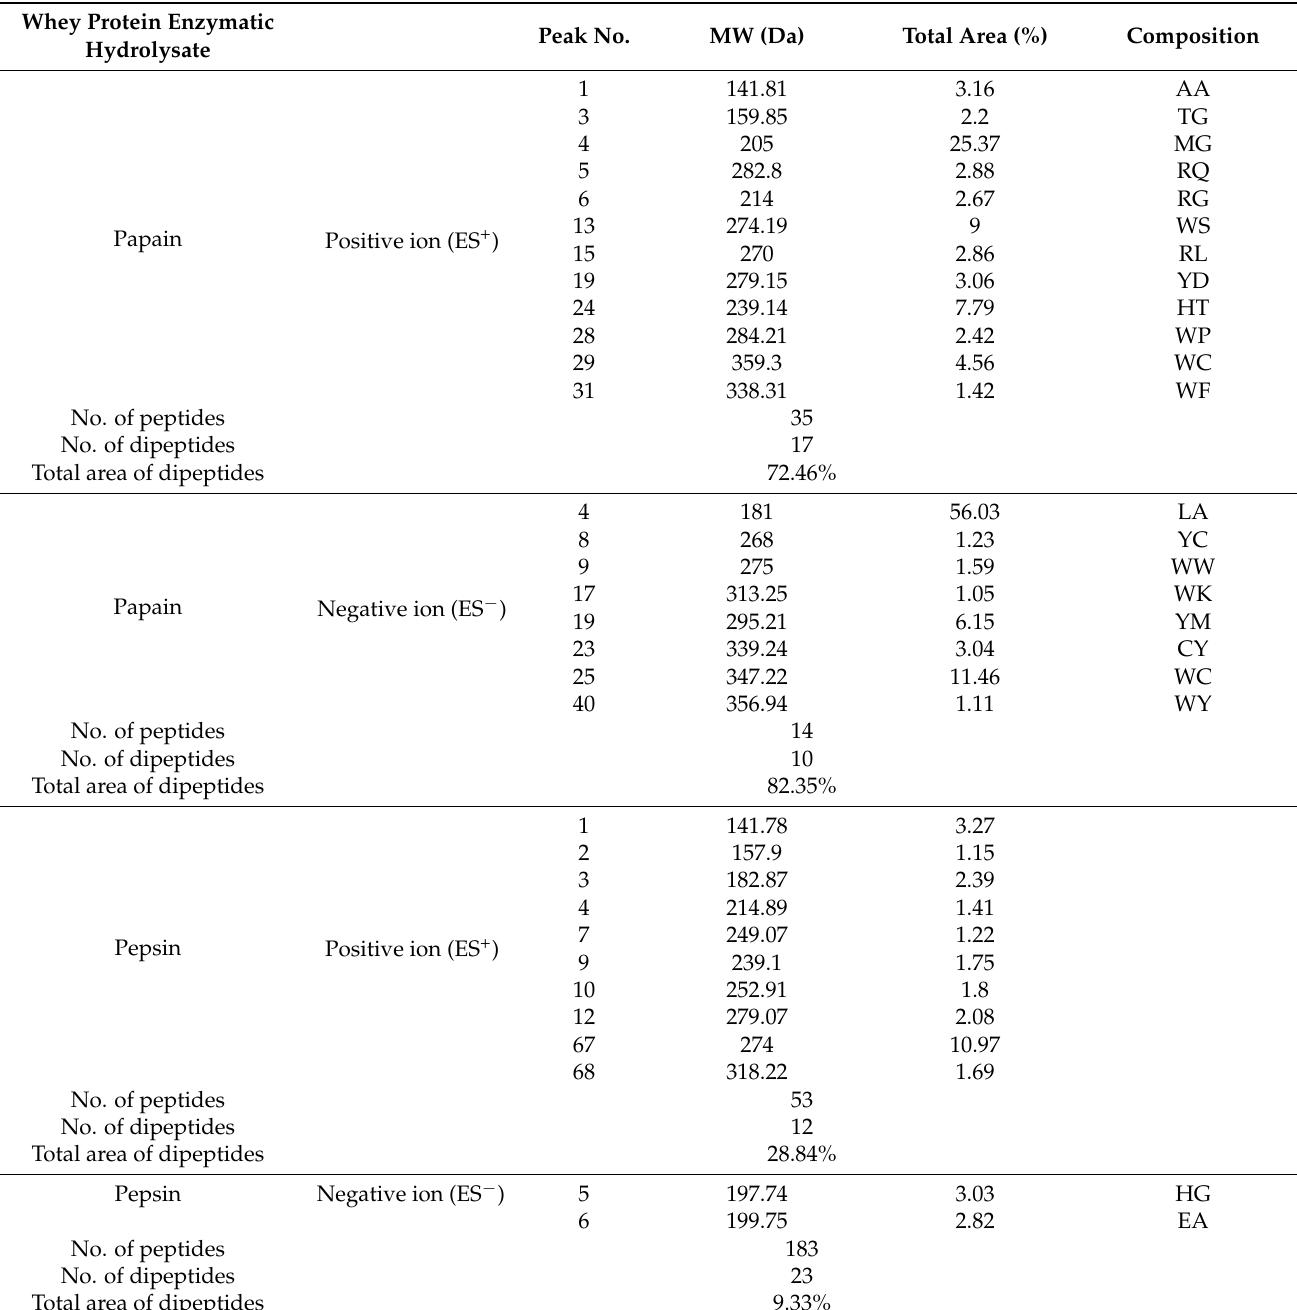
Table 1. Possible peptide compositions of whey proteins hydrolyzed with papain and pepsin, including positive and negative